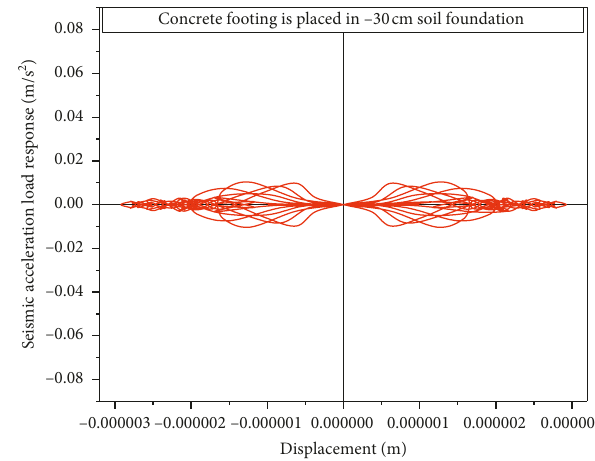
Figure 5: Seismic acceleration load response vs displacement at the base of a concrete footing, during concrete footing-soil foundation interaction.